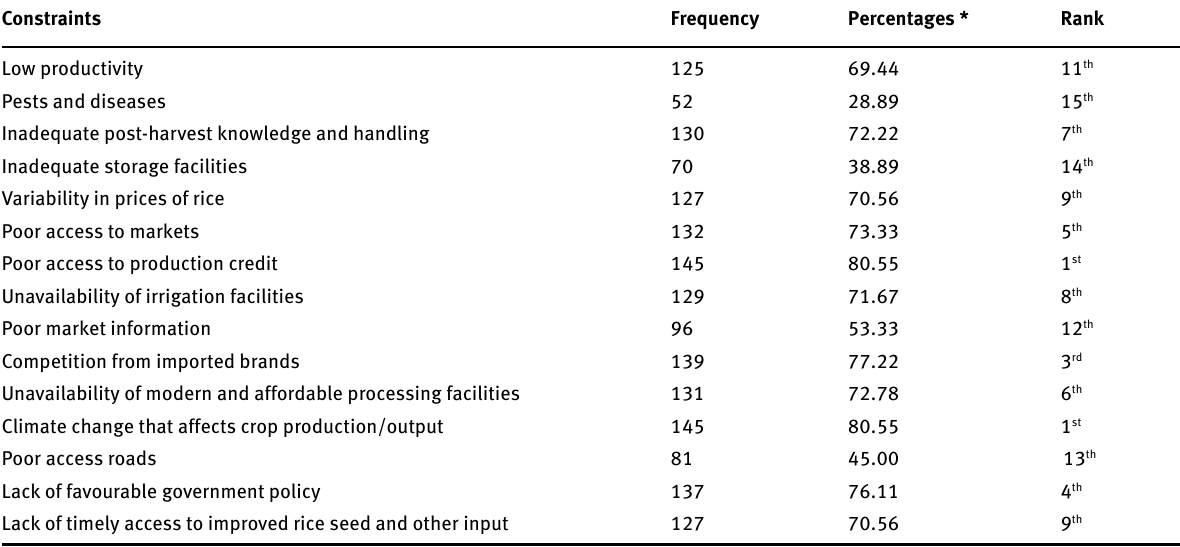
Table 6: Factors constraining rice farmers in Ebonyi State (n=180)